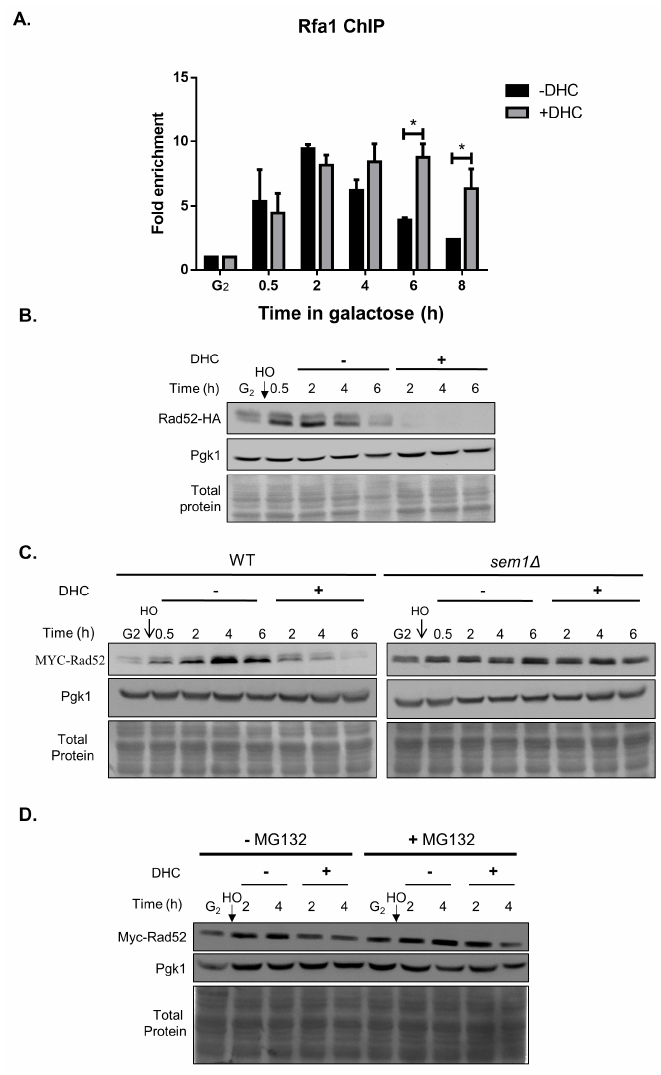
Figure 4. Rad52 protein expression is inhibited by DHC following DNA damage. ( A ) RFA1-MYC cells (YAY022) were arrested at G2 with 15 µg/mL nocodazole, and HO endonuclease was induced by the addition of galactose to generate a DSB. After 30 min, the cultures were divided equally and treated with or without 5 mM DHC. The recruitment of Rfa1 to flank the HO lesion was analyzed by ChIP. The error bars represent the standard deviations from at least three independent experiments. Asterisks (*) indicate significant differences between DHC-treated and untreated cells (* p < 0.05); ( B ) RAD52-HA cells (YAY013) were arrested at G2 with nocodazole, and HO endonuclease was induced by the addition of galactose to generate a DSB. After 30 min, the cultures were divided equally and treated with or without 5 mM DHC. Whole-cell extracts were analyzed by immunoblotting at the indicated time points; ( C ) The WT ( RAD52::MYC ) cells (YAY028) or sem1 mutant cells (RLY006) were arrested at G2, and HO endonuclease was induced by the addition of galactose at time 0 to generate a specific DSB. The culture was then split into two groups, namely, − DHC (WT) and +DHC (5 mM DHC), and samples were then processed for immunoblotting analysis; ( D ) DHC inhibits Rad52 recombinase protein levels after MG132 treatment following DNA damage. RAD52::MYC cells (YAY028) were arrested at G2 with nocodazole, and HO endonuclease was induced by the addition of galactose at time 0 to generate a specific DSB. The culture was then split into four groups: − DHC (5 mM) − MG132 (1 mM), +DHC − MG132, − DHC +MG132 and +DHC +MG132. Samples collected at the indicated time points were then processed for immunoblotting analysis. The Pgk1 protein level and total protein, as assessed through amido black staining, served as loading controls.